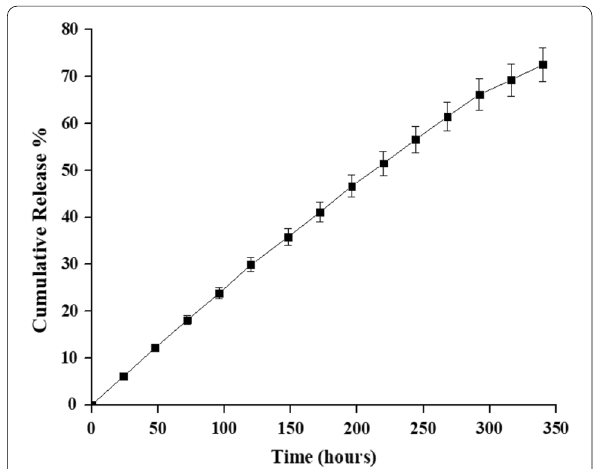
Fig. 6 Release profile of BSA-loaded nanoparticles at pH 7.4